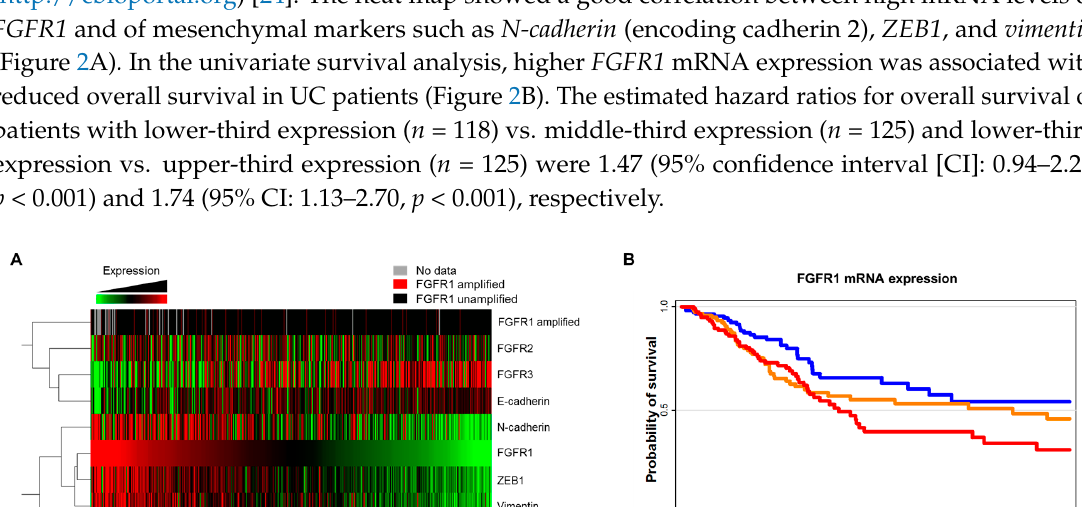
Figure 1. FGFR1 expression is correlated with EMT features and PTX resistance in UC cell lines. ( A ) T24, J82, RT4, UMUC-14, HTB5, and HTB9 cells were evaluated basal expression of FGFRs and EMT-associated proteins by Western blotting; β -actin served as a loading control. ( B ) Colony formation assay. T24, J82, RT4, and UMUC-14 cells were grown for 7 days, then stained with Coomassie Brilliant Blue and counted. ( C ) T24, J82, RT4, and UMUC-14 cells were treated with 0, 1, 10, 100, and 1000 nM PTX for 3 days. IC 50 values were calculated using CalcuSyn (BioSoft, Ferguson, MO, USA). Data represent the mean ± standard deviation of five replicates. ( D ) Cell cycle analysis by propidium iodide staining and flow cytometry. A total of 1 × 10 6 cells were seeded in 60-mm plates and treated with 0, 5, and 10 nM PTX for 48 h. Data are presented as histograms (blue, G0/G1 phase; green, S phase, and red, G2/M phase). ( E ) Cyclin B , p21 , p27 , γ -H2AX , caspase-3 , and PARP expression in T24, J82, UMUC-14, and RT4 cells, as determined by Western blotting; β -actin served as the loading control.